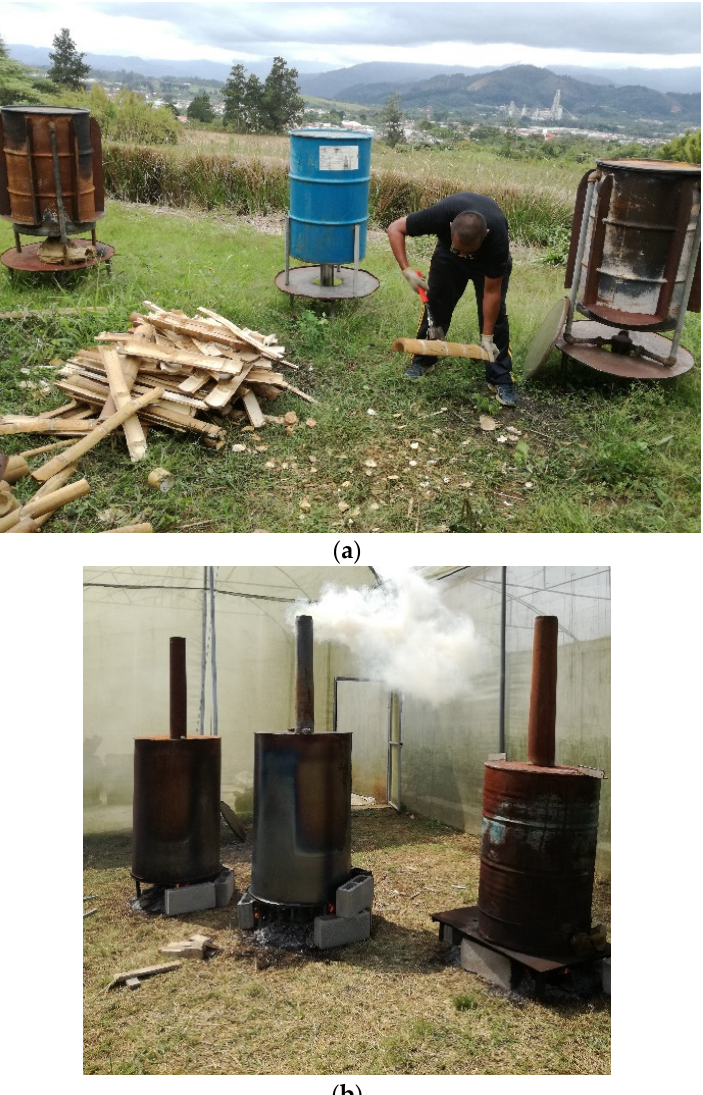
Figure 1. Carbonization kilns designed at the Costa Rica Institute of Technology for biochar produc- tion: ( a ) pyrolysis chambers of three kilns (behind) and halved bamboo stems (at left); ( b ) reactor during production.